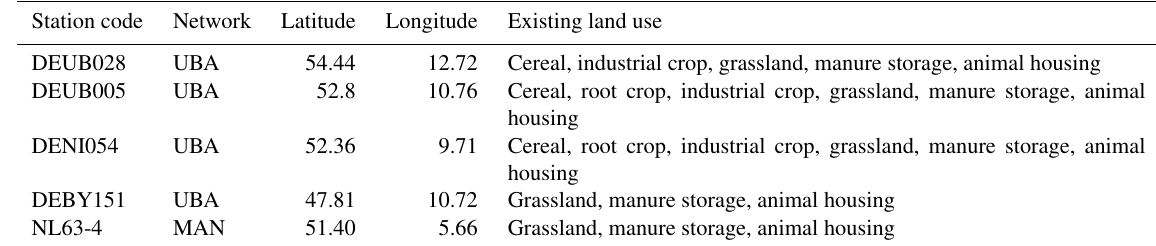
Table I1. Information on the selected in situ measurement